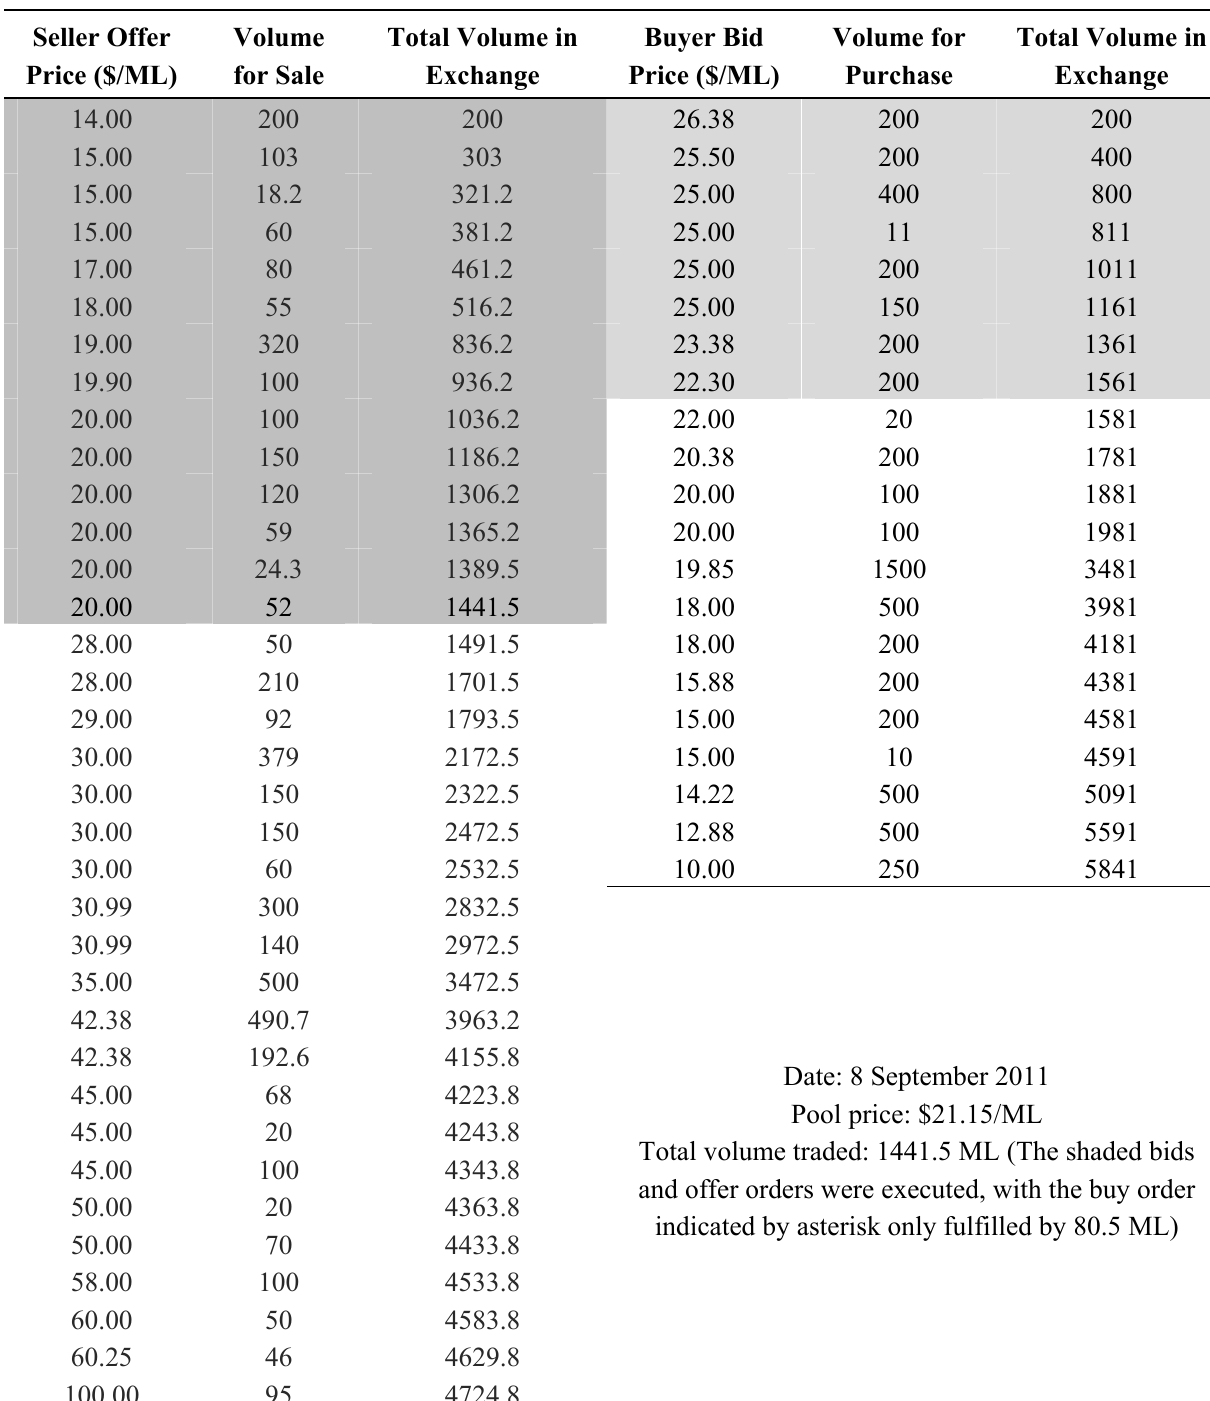
Table 1. An example of Watermove weekly exchange bids and offers.